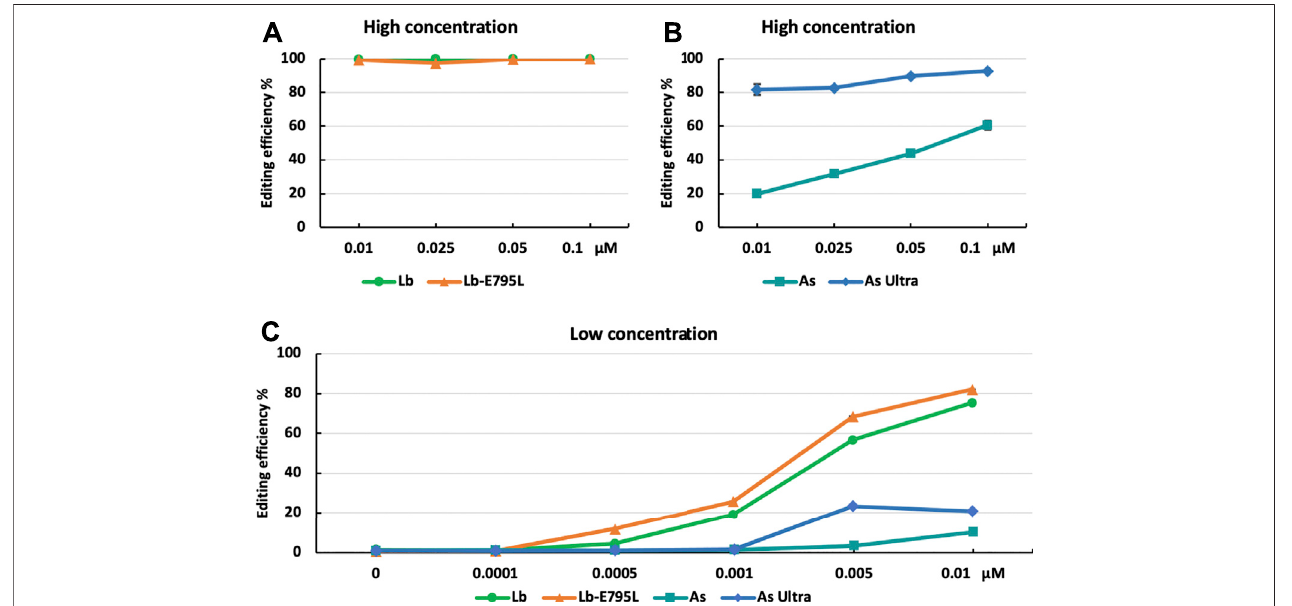
FIGURE 3 | Cas12a editing ef fi ciencies at different dosages in rice cells with RNP delivery. Editing ef fi ciencies of four Cas12a variants were tested in rice cells with RNPdeliveryat the OsEPFL9 siteat 32 ° C.Editingef fi cienciesarecalculatedusing theRFLPassaywithhigh RNPconcentrations (A,B) and lowRNPconcentrations (C) . Data are presented as mean values ±SEM of three biologically independent